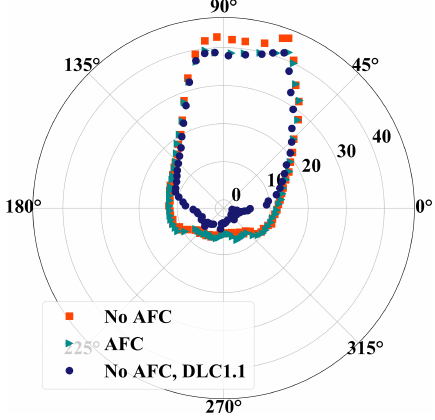
) for different load directions. In XY and 90 ◦ to positive X